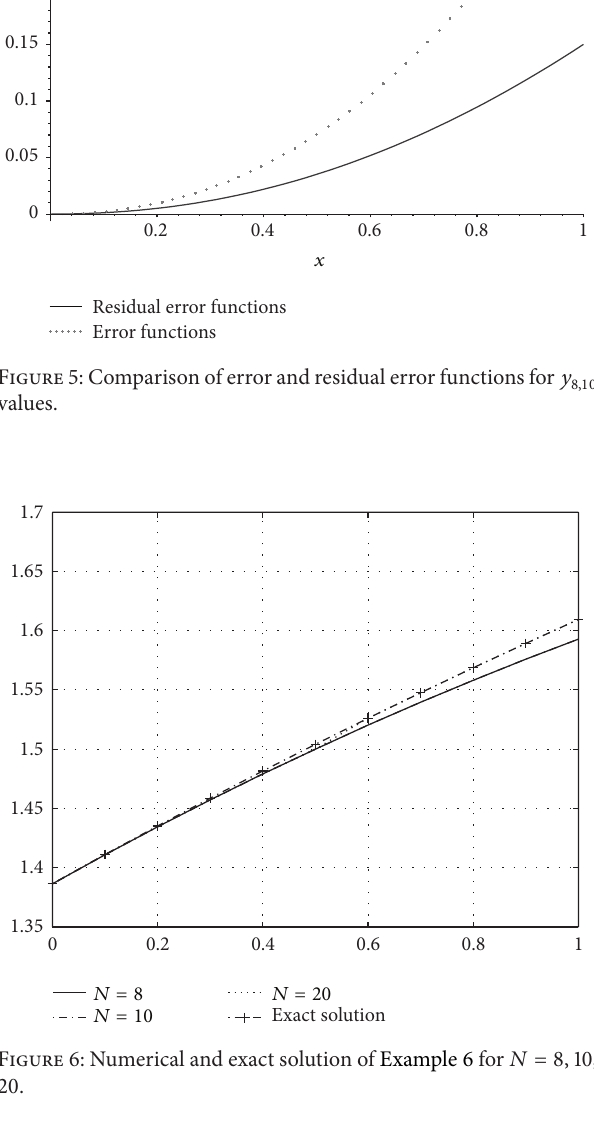
Figure 6: Numerical and exact solution of Example 6 for 𝑁 = 8 , 10, 20.